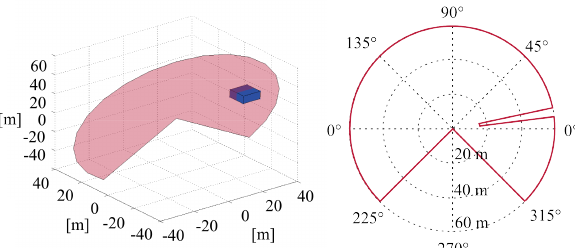
Figure 7: On the left: Visualization of the detection of the UAV with the laser scanner. On the right: Measurement in laser scan- ner plane which is delivered by the simulation